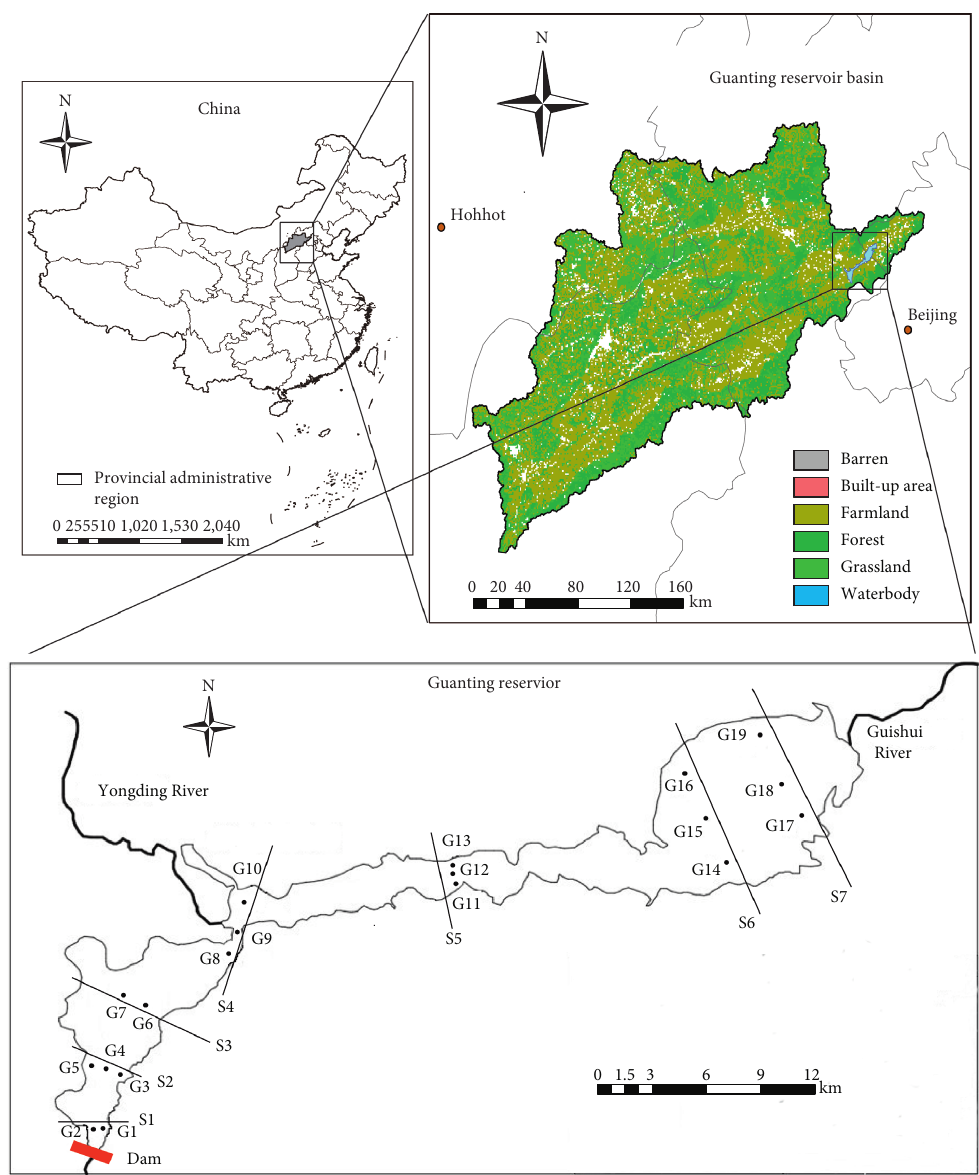
Figure 1: Map of sampling points in the Guanting